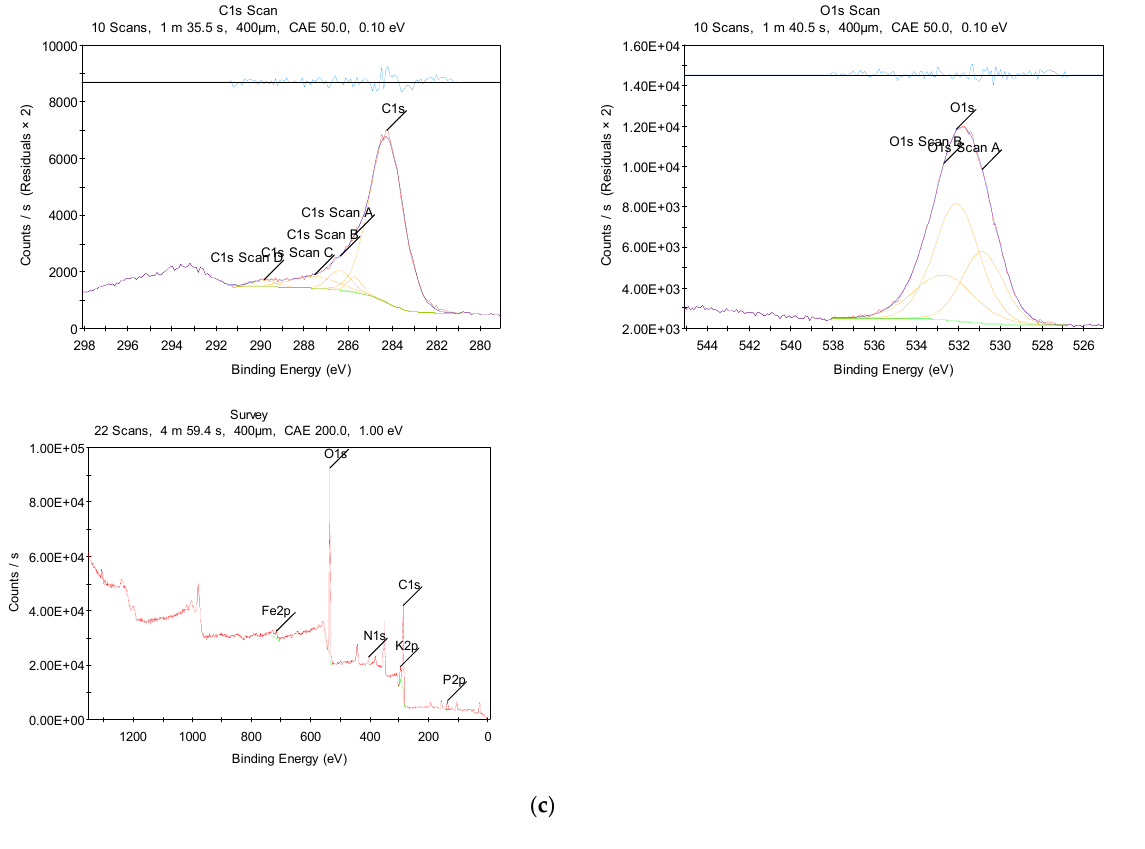
Figure 4. ( a ). XPS analyses of waste tea leaf: C 1s spectrum, O 1s spectrum, and survey spectrum. ( b ). XPS analyses of biomass-derived-ACs: C 1s spectrum, O 1s spectrum, and survey spectrum. ( c ). XPS analyses of Fe 3 O 4 -carbon-based composite material: C 1s spectrum, O 1s spectrum, and survey spectrum. Table 2. Elemental composition of the waste tea leaf, biomass-derived-ACs, and the Fe 3 O 4 -carbon- based composite as measured by XPS.